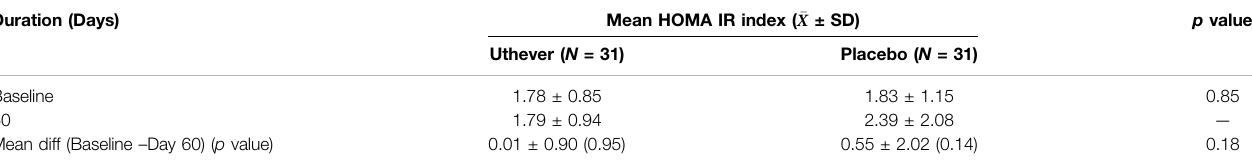
TABLE 6 | Comparison of changes in mean HOMA IR index between groups.